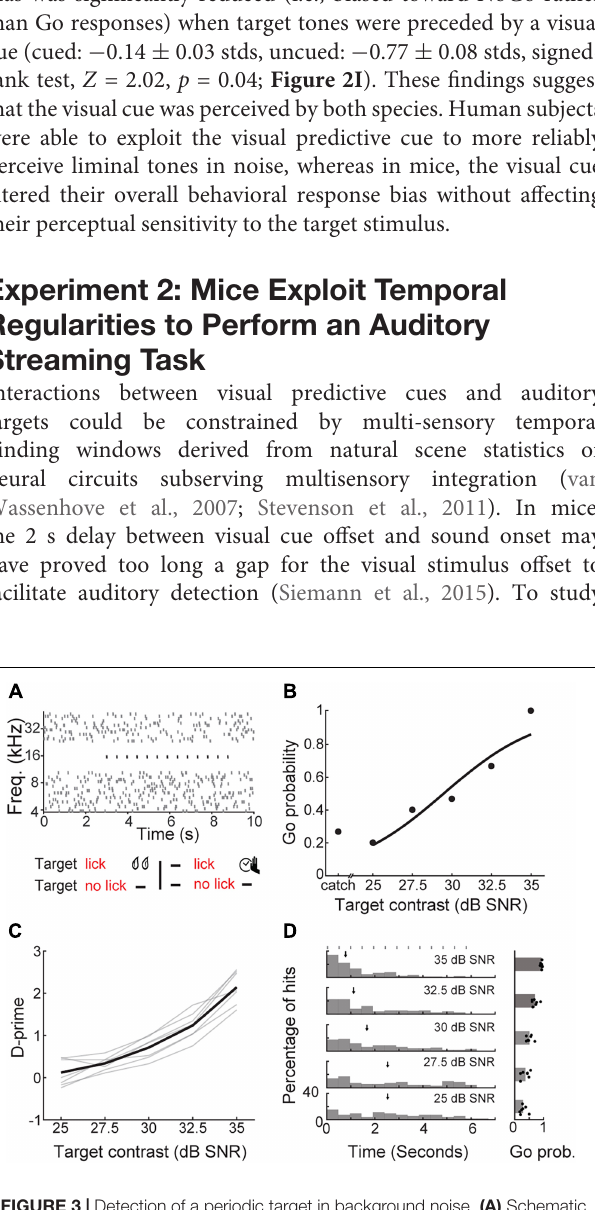
FIGURE 3 | Detection of a periodic target in background noise. (A) Schematic of a Go/No-Go detection task that required mice to report the perception of a repeating target tone in the presence of a tone cloud background. Top; the stimulus spectrogram for a trial in which the repeated target tone (black dots) begins 3 s after the onset of the random, serially presented masking tones (gray dots). Bottom; task contingencies. (B) Go probability as a function of target contrast for a single representative session. (C) D-prime as a function of target contrast, showing the mean (black line) and individual mice (gray lines). (D) Left, reaction time distributions as a function of target contrast. Median reaction times are indicated with arrows. Target burst timing is indicated by gray rectangles. Right, Go probability as a function of target contrast, showing the mean and individual values